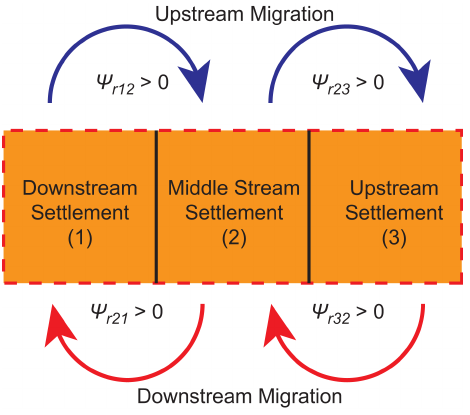
Figure 3. Schematic diagram describing the framework adopted in the model for internal relocation of humans between the three set- tlements (see Eqs.